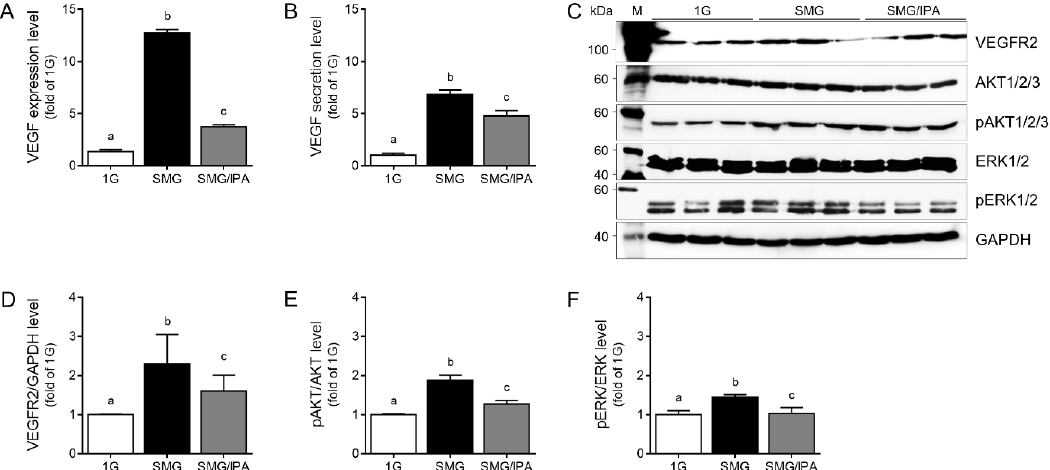
Figure 4. The inhibitory effects of VEGFR2 signaling by VEGFR2 docking with IPA in microgravity- stimulated ARPE19 cells. ( A ) VEGF expression levels in cell lysate and ( B ) secretion levels in conditioned medium were detected by ELISA on day 7 after microgravity stimulation with or without IPA. ( C ) Expression levels of VEGFR2 and its related proteins, including AKT and ERK, in microgravity-stimulated ARPE19 cells with PBS (SMG; black) or 2.5 nM IPA (SMG/IPA; gray) were validated by Western blotting. ( D ) VEGFR2, ( E ) phosphorylated AKT, and ( F ) ERK were quantified by Image J software. Means denoted by different letters indicate significant differences between the groups ( p < 0.05). SMG, simulated microgravity; IPA, ishophloroglucin A; VEGF, vascular endothelial growth factor; VEGFR2, vascular endothelial growth factor receptor 2.